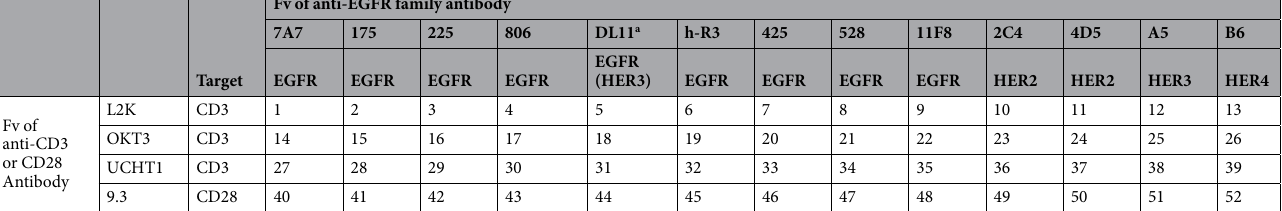
indicate that dilution of culture supernatant at more than 10-fold can be used to avoid the influence of cytotoxic media components. Figure 1 shows the results of the MTS assays of 10-fold and 100-fold diluted culture supernatants containing each of the 104 diabodies constructed here. Each of diabody-expressing E. coli was grown in a 500 mL-sized shake flask containing 250 mL medium, and the culture supernatants were used. Overall, a higher degree of cytotox- icity against TFK-1 cells was achieved with LH-type diabodies than with HL-type diabodies. Both HL-type and LH-type diabodies with anti-CD28 domains (i.e., diabodies nos 40–52, Fig. 1) caused only a low degree of cyto- toxicity, whereas LH-type diabodies with domains from any of the three anti-CD3 Fvs (i.e, diabodies nos 1–39, Fig. 1) caused a substantial degree of cytotoxicity. However, HL diabodies containing the anti-CD3 domains from the UCHT1 Fv (i.e., diabodies nos 27–39, upper panel, Fig. 1) showed relatively high activity compared with those containing domains from other anti-CD3 Fvs.